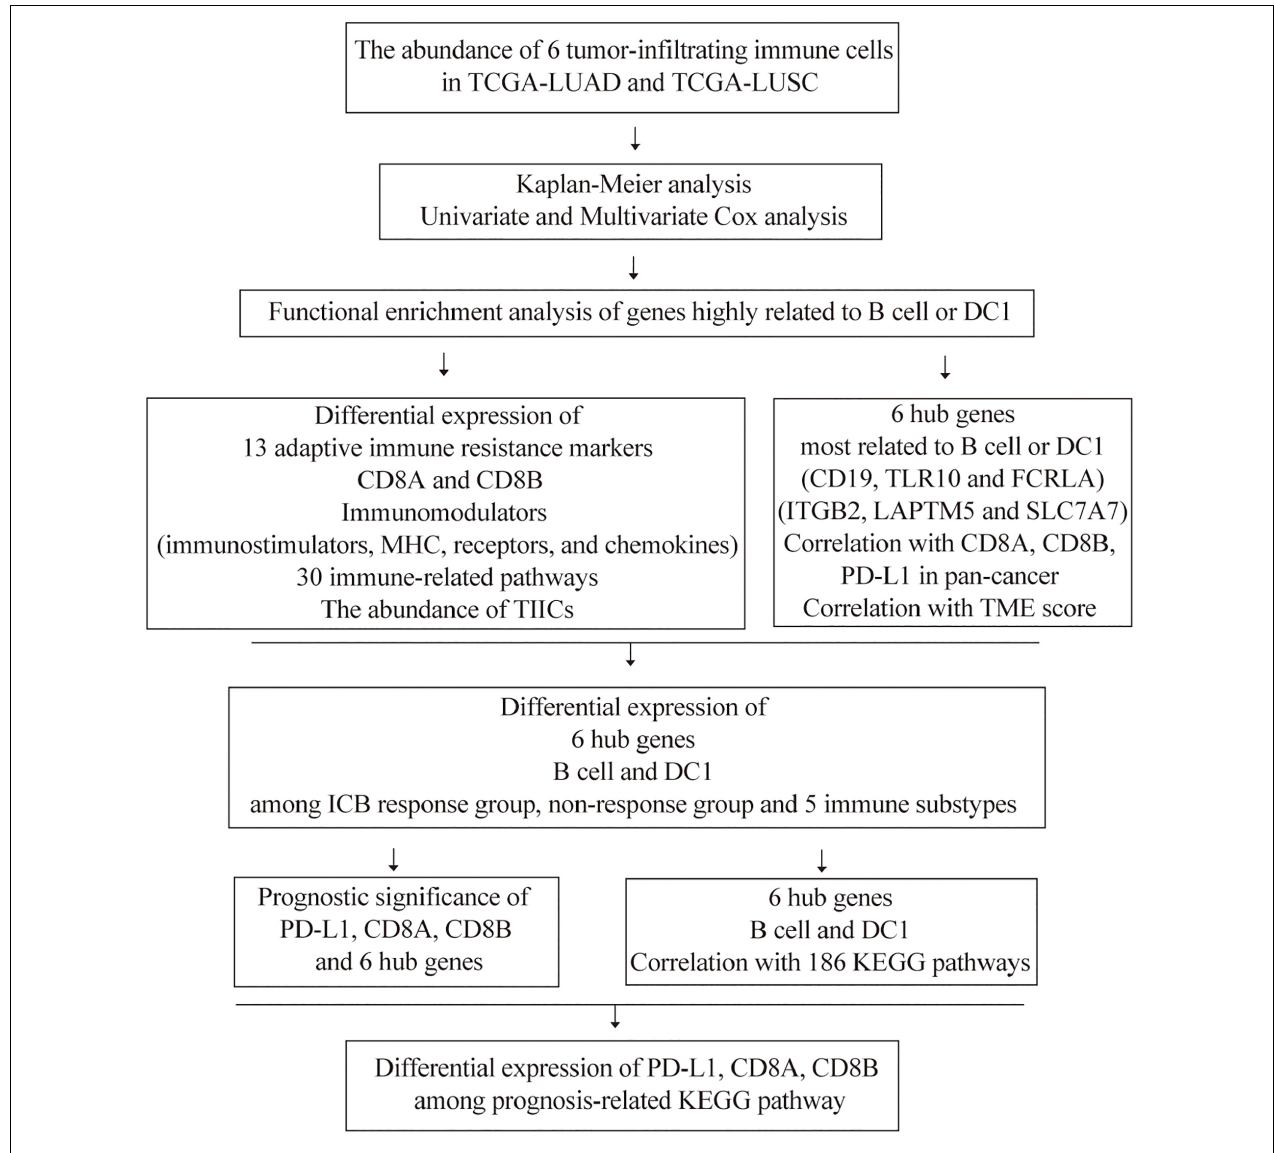
FIGURE 1 | The flowchart of this